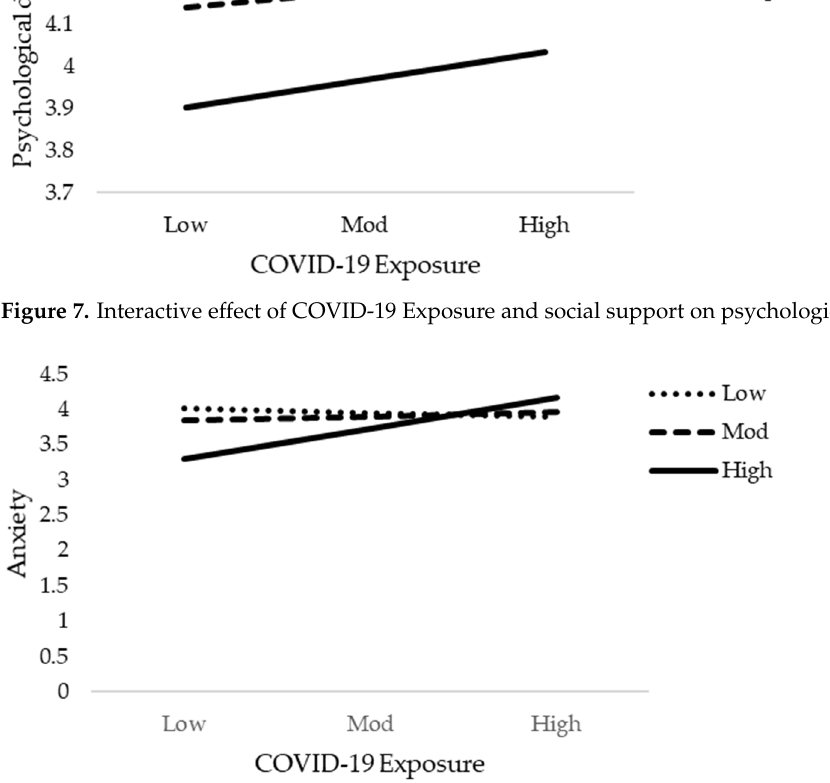
Figure 8. Interactive effect of COVID-19 Exposure and social support on Anxiety.